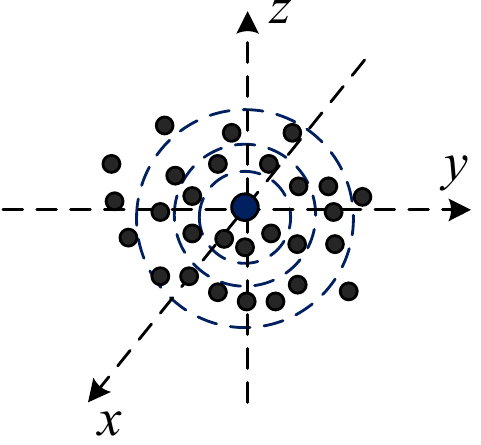
Figure 4. Multi-scale selection.